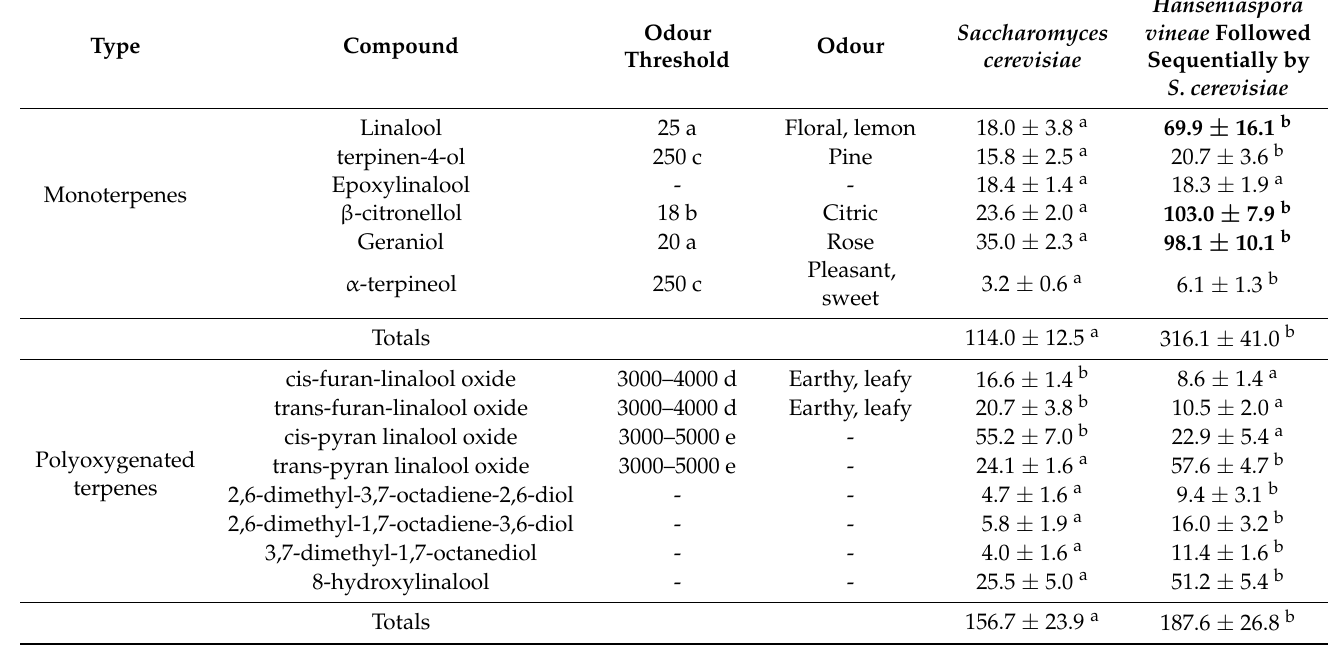
Table 1. Concentrations of terpenes and polyoxygenated terpenes ( µ g/L) in wines fermented by Saccharomyces cerevisiae and by Hanseniaspora vineae followed sequentially by S. cerevisiae . Values are means ± standard deviations ( n = 3). A different letter in the same row means significant differences ( p < 0.05). Values in bold type are those with high differences and above the odour threshold in